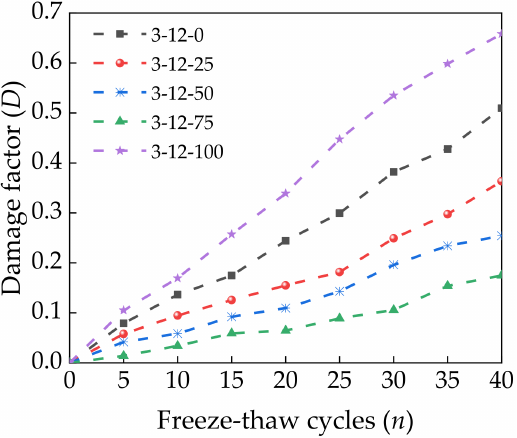
Figure 11. Relationship between freeze–thaw cycles and the freeze–thaw damage factor D .